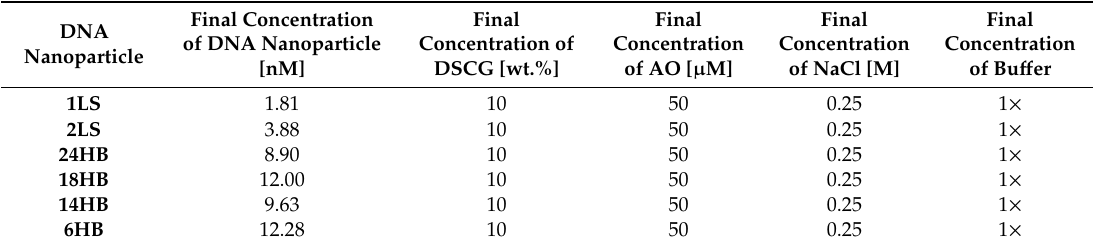
Table A2. Final concentration of the DNA nanoparticle, DSCG, acridine orange (AO), NaCl and bu ff er in the mixture. DNA